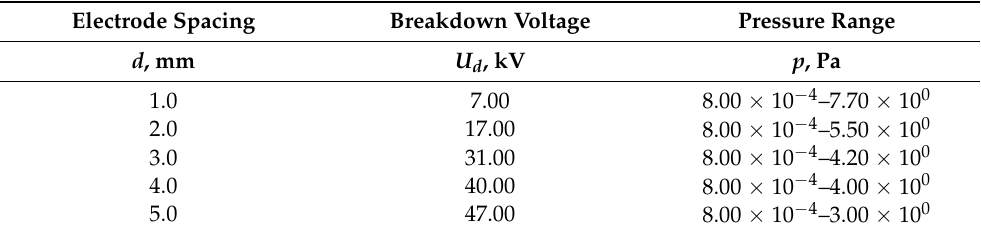
Table 4. The measured values of the breakdown voltages U d in the compartment with constant dielectric strength for a vacuum interrupter with residual gases being pure air.